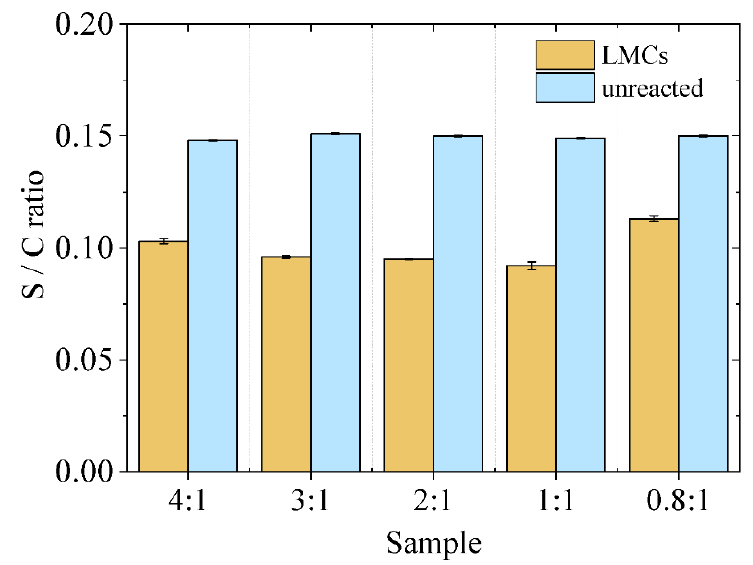
Figure 5. Sulfur to carbon ratio of capsule-forming and unreacted SLS.